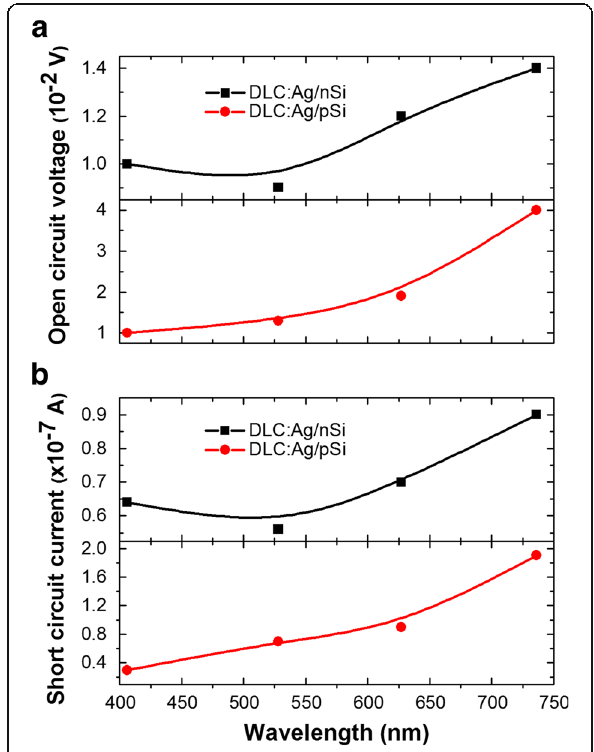
Fig. 6 The dependence of the open circuit voltage ( a ) and short circuit current ( b ) on excitation wavelength for DLC:Ag/n-Si and DLC:Ag/p-Si